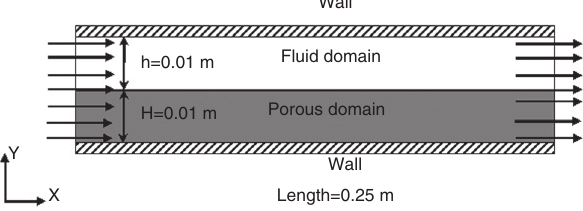
Figure 9 Schematic representation of fully developed flow in porous/fluid domain [49].